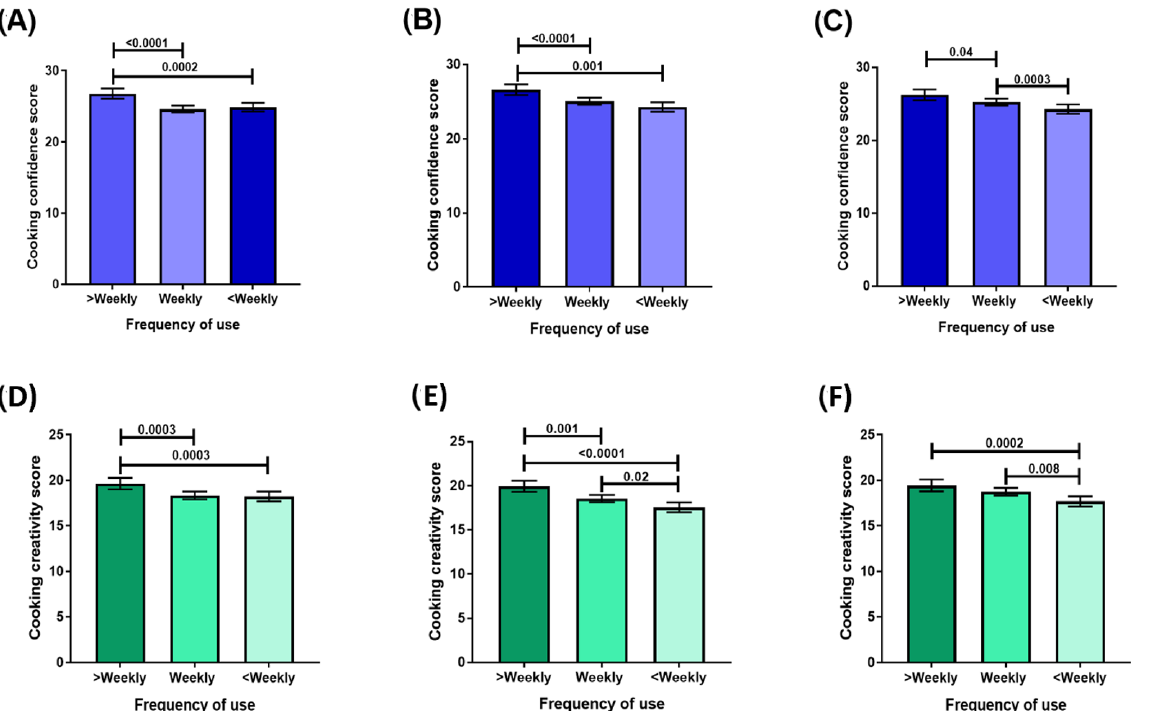
Figure 1. Cooking confidence scores by frequency of use of convenience cooking products: ( A ) meal and recipe bases; ( B ) simmer sauces; ( C ) pasta sauces. Cooking creativity scores by frequency of convenience cooking product use: ( D ) meal and recipe bases; ( E ) simmer sauces; ( F ) pasta sauces.